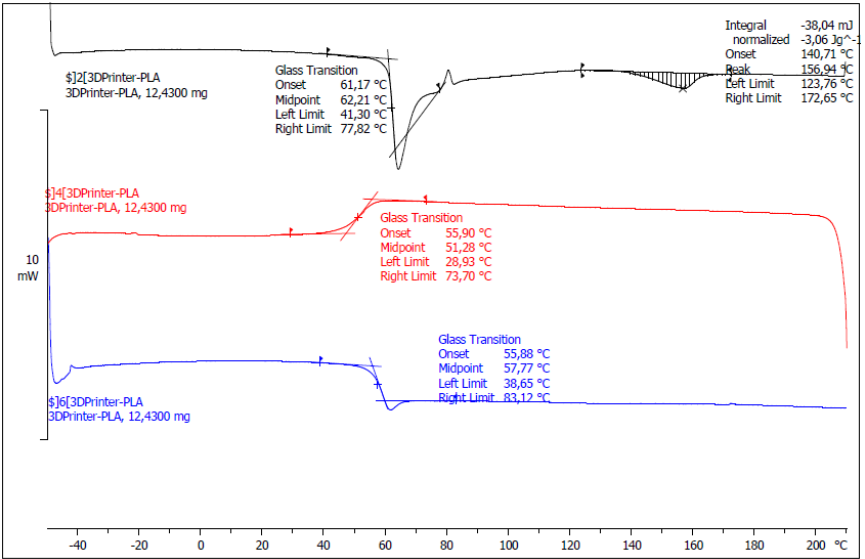
Figure 3. Thermal transitions of PLA filament assessed using two heating and one cooling run in DSC.